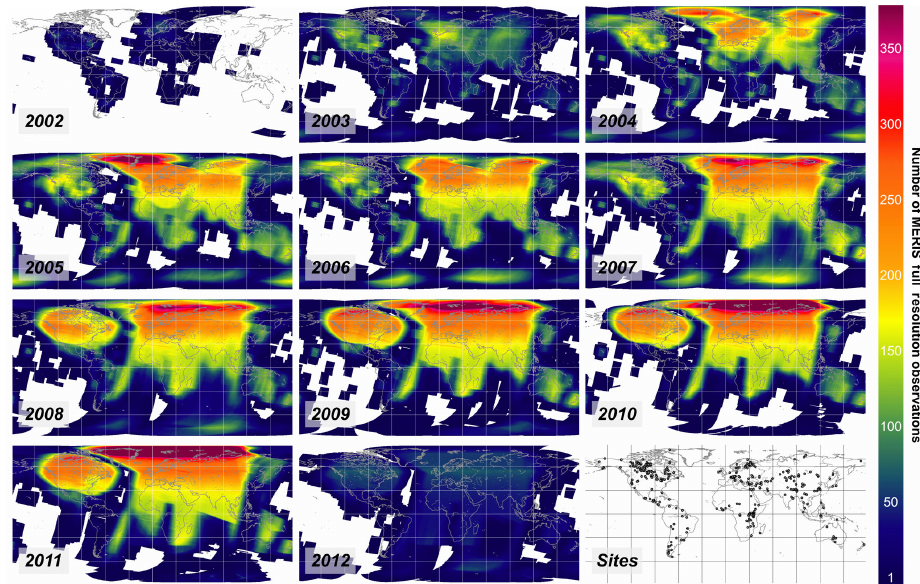
Figure 1. Global density maps for the bulk reprocessed MERIS FR dataset in the years 2002–2012, and distribution of the 340 lakes available in the Diversity II water quality dataset (bottom